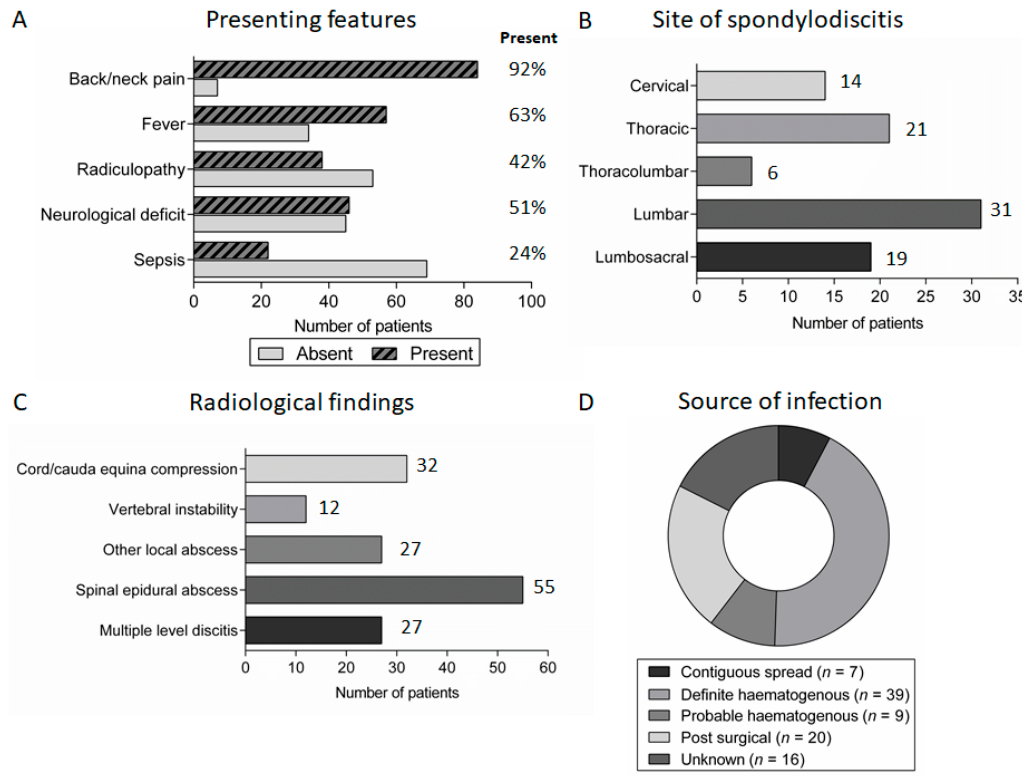
Figure 2. Symptoms, radiological features and underlying source of spondylodiscitis: ( A ) the presence/absence of important symptoms in patients presenting with discitis; ( B ) the distribution of spondylodiscitis between different anatomical regions; ( C ) the number of patients with complications of spondylodiscitis identified on MRI imaging at presentation; and ( D ) the underlying source of infection in patients with spondylodiscitis.